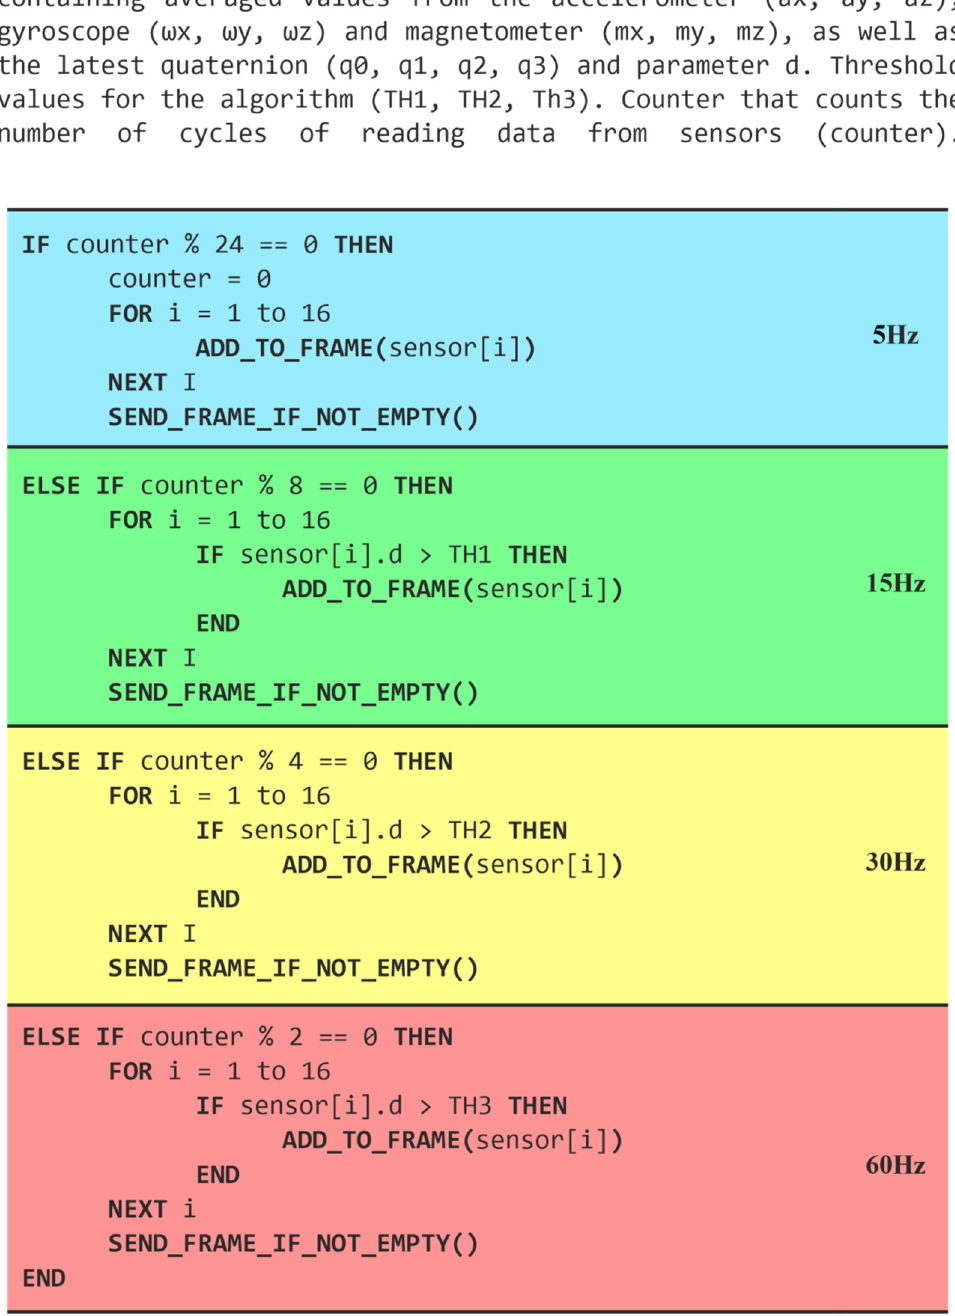
Figure 7. Pseudocode for the transmission control algorithm.